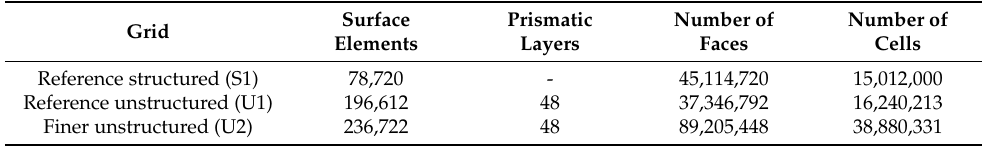
Table 1. Features of the grids: structured versus unstructured